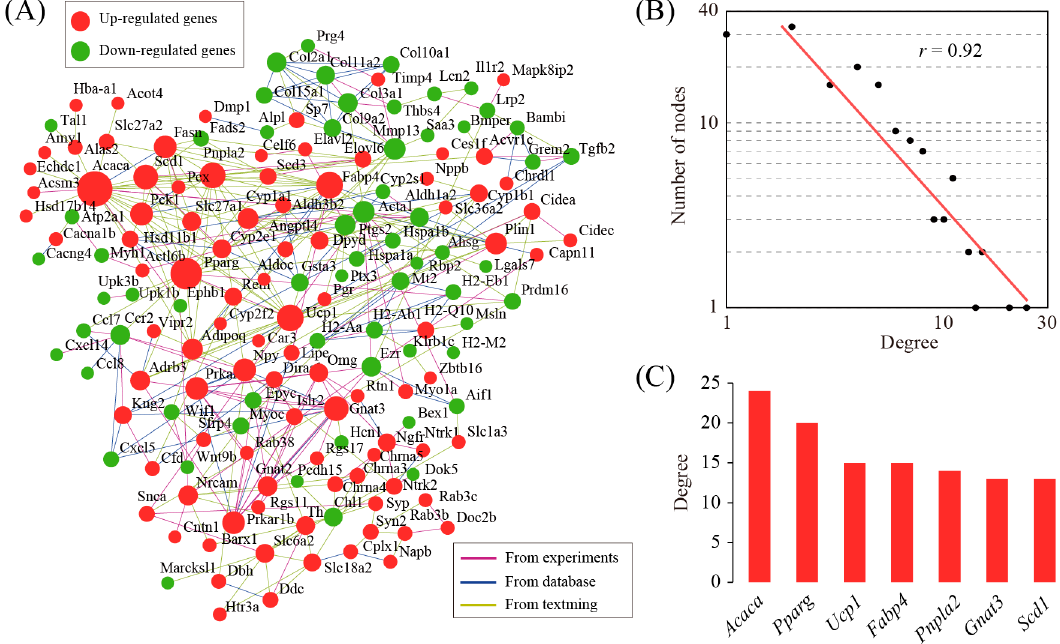
Figure 3. Gene network analysis of differentially expressed genes. ( A ) The structure of gene network underlying differentially expressed genes. This analysis was performed by using the STRING software. Nodes represent genes and edges represent gene–gene interactions. The diameter of each node is proportional to its degree value. This graph was generated using the Cytoscape software; ( B ) The degree distribution of the network, which follows a power law distribution; ( C ) Identification of hub genes in the gene network.